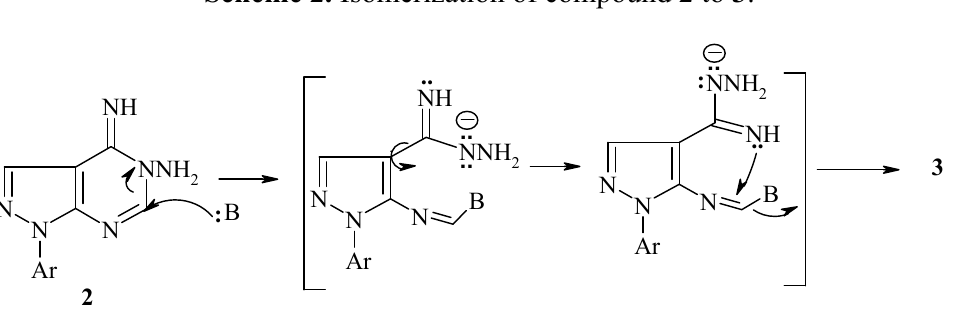
Scheme 2. Isomerization of compound 2 to 3